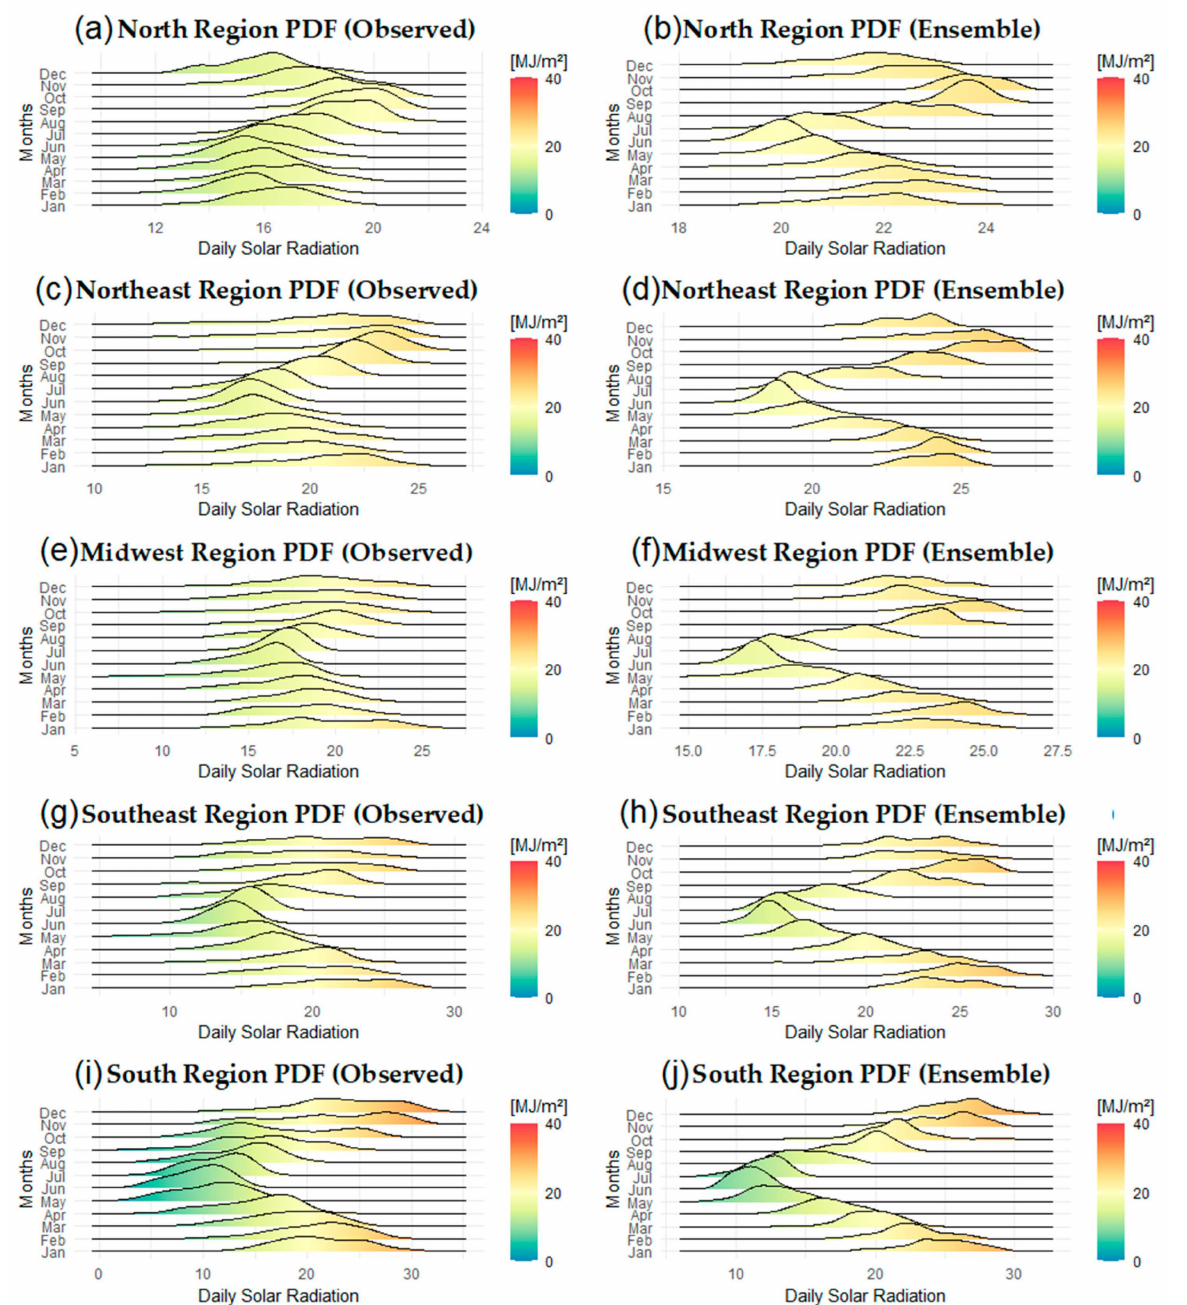
Figure 10. Solar radiation probability density (MJ/m 2 ), with observed data on the left and BAM data on the right, for each Brazilian region: NO ( a , b ), NE ( c , d ), CO ( e , f ), SE ( g , h ), and S ( i , j